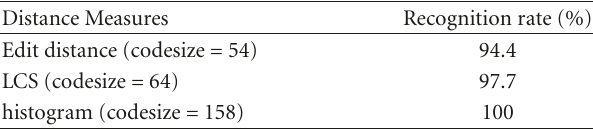
Table 2: Action recognition using di ff erent distance measures.